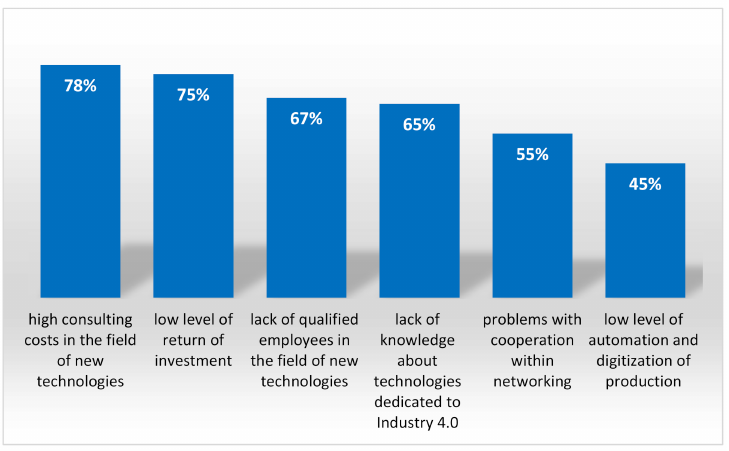
Figure 4. The main concerns of the Industry 4.0 technologies’ implementation. Source: own